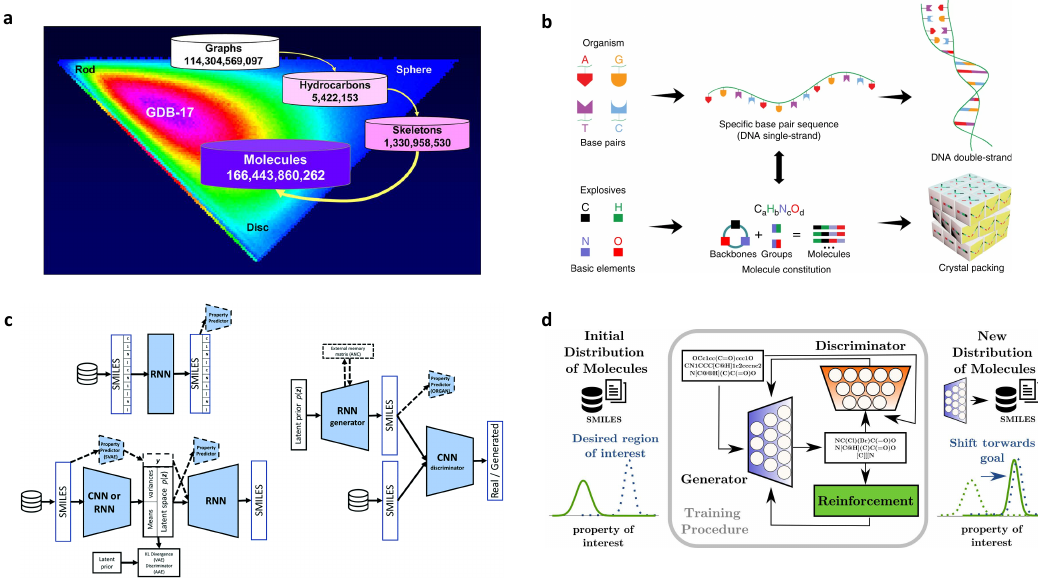
Figure 11. Typical molecular generation methods. ( a ) GDB molecular database generated by direct enumeration (adapted from Reference [23] with permission, copyright 2012 American Chemical Society); ( b ) high-energetic molecules generated by a material genome approach (adapted from Reference [52] with permission, copyright 2018 Springer Nature); ( c ) molecular generation by CNNs or RNNs with SMILES representation (adapted from Reference [60] with permission, copyright 2019 Royal Society of Chemistry); ( d ) molecular generation by generative adversarial network (GANs) using SMILES representation (adapted from Reference [25] with